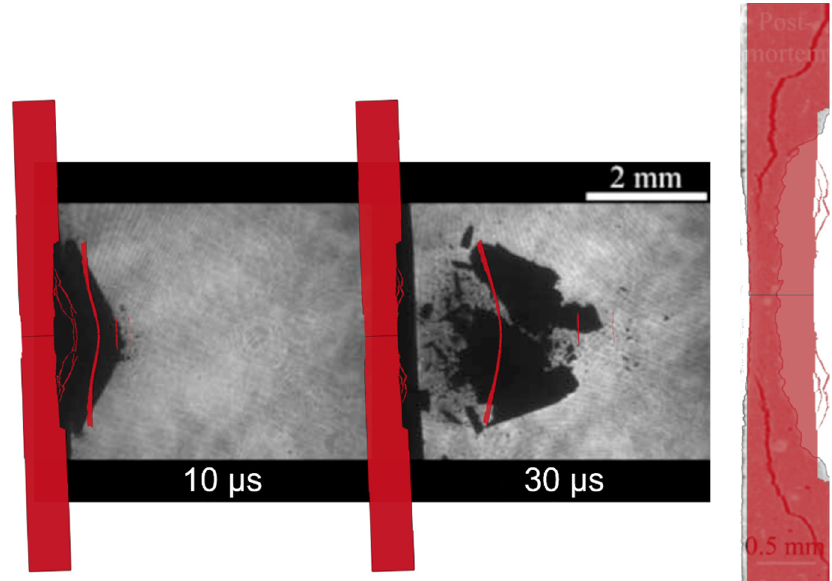
Figure 13. Shot N16 comparison between: numerical simulation results and shadowgraphies (reprinted from [28]). ( left ); post-mortem numerical simulation and tomography (reprinted from [28]). ( right ).